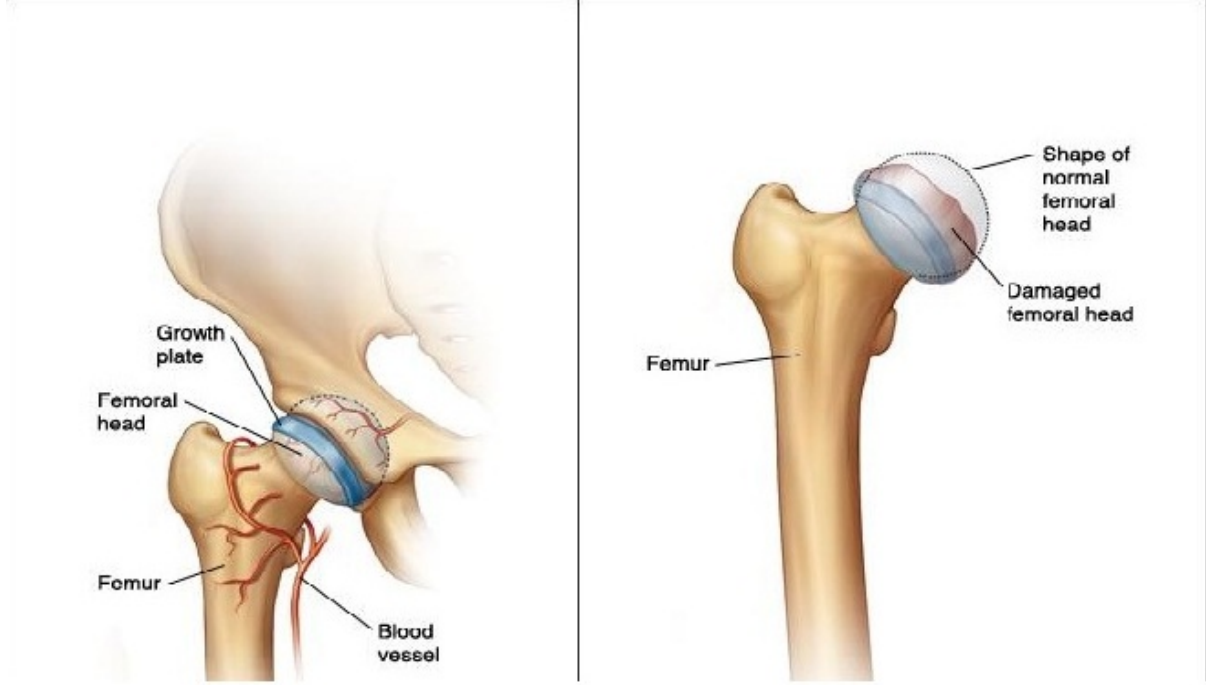
Figure 1. In the normal hip joint, the femoral head is smooth and round (left). In Perthes disease, the femoral head is damaged and loses its normal shape